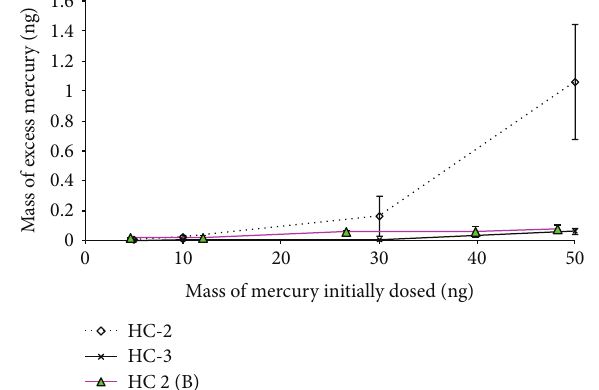
Figure 4: Results of intermediate-term Exp. B (Exp. no. 3). Amount of excess mercury (ng) from the second heating cycle (HC-2) after 7 days and third heating cycle (HC-3) after 14 days was measured: results compared as a function of the mass of mercury originally dosed onto the adsorption tubes in day 1 ( 𝑥 -axis). Each measurement point (HC-2 and HC-3) for initial injection of 5, 10, 30, and 50ng of mercury is average of triplicate tube analyses, and a total of 12 different tubes were used for this investigation. Error bars represent standard deviation of triplicate analyses. HC- 2 (B) represents observation from the second heating cycle in our previous investigation